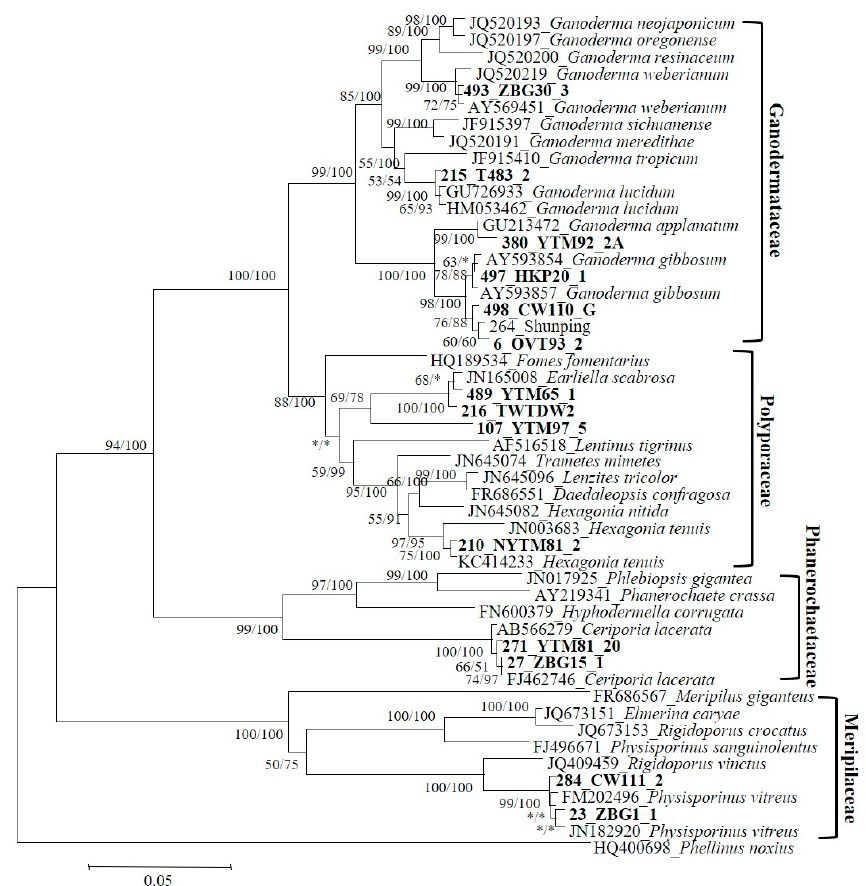
Figure 3. A neighbor-joining tree generated with ITS rDNA using MEGA 5.05 showing the phylogeny of Polyporales species detected in this study. The numbers in front of the slashes show bootstrap (1000 replications) values (%) of the branches, and the numbers behind the slashes show Bayesian posterior probability (%) generated with BEAST v1.5.4. Values that are less than 50% were substituted with asterisk marks. The best model for Bayesian analysis was HKY + I + G, selected using MrModeltest 2.2. Sequences in bold indicate fungal species obtained from this study.